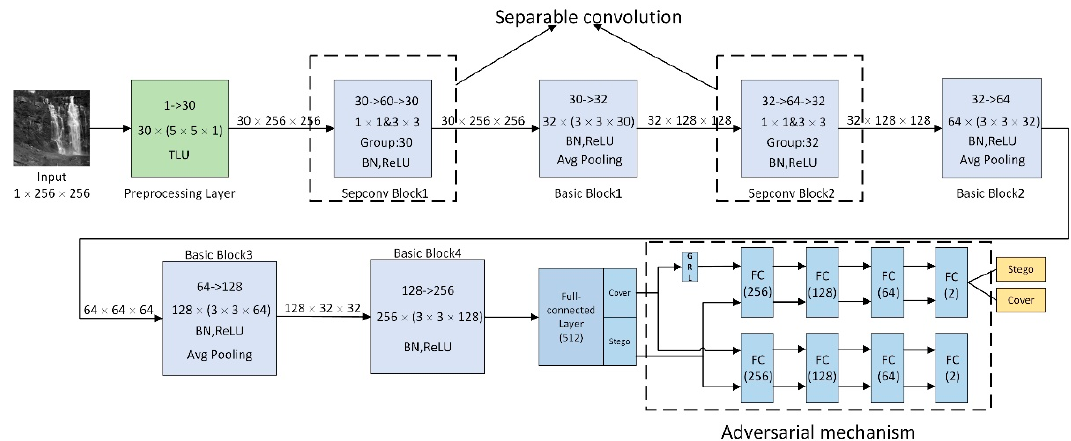
Figure 1. Architecture of the proposed CNN: For each block, x 1 → x 2; x 2 × (a × a × x 1 ) denotes the block with the kernel size a × a for x 1 input feature maps and x 2 output feature maps. Batch normalization is abbreviated as BN. Fully connected layer is abbreviated as FC.